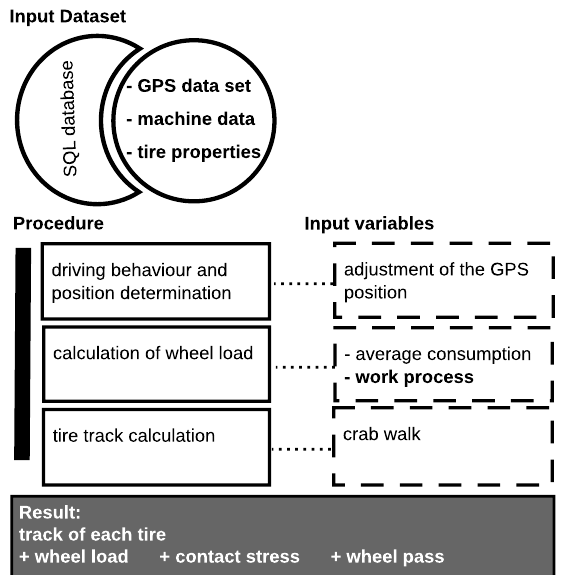
Figure 2. A simplified work flow for a selection of the modeling procedure of FiTraM according to [26]. The Input variables in bold are required, the others are